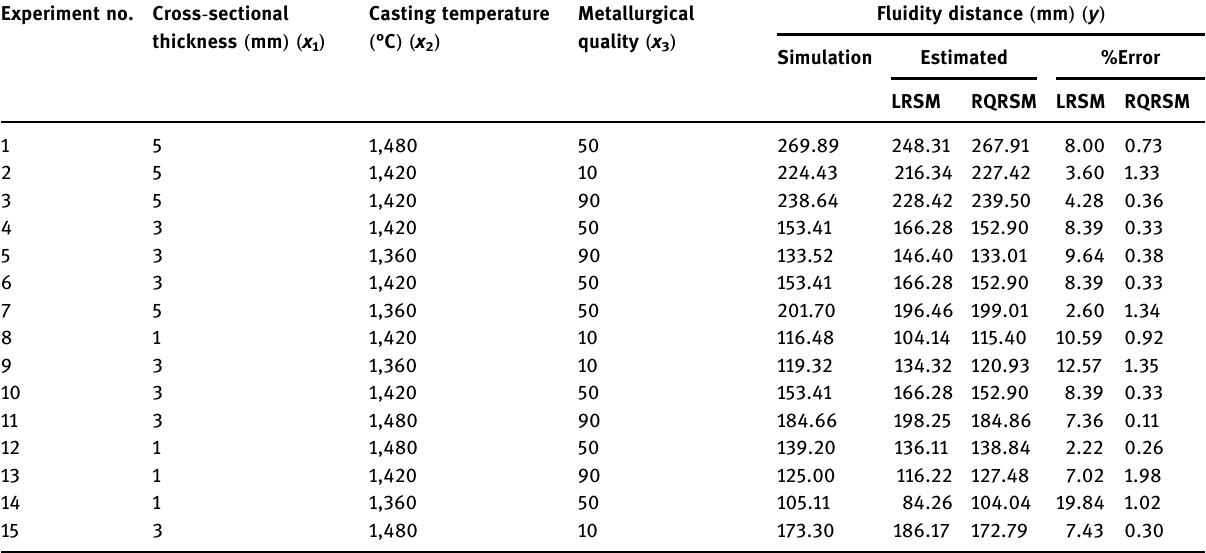
Table 3: Experimental design based on BBD and the response values Experiment no. Cross - sectional thickness ( mm ) ( x 1